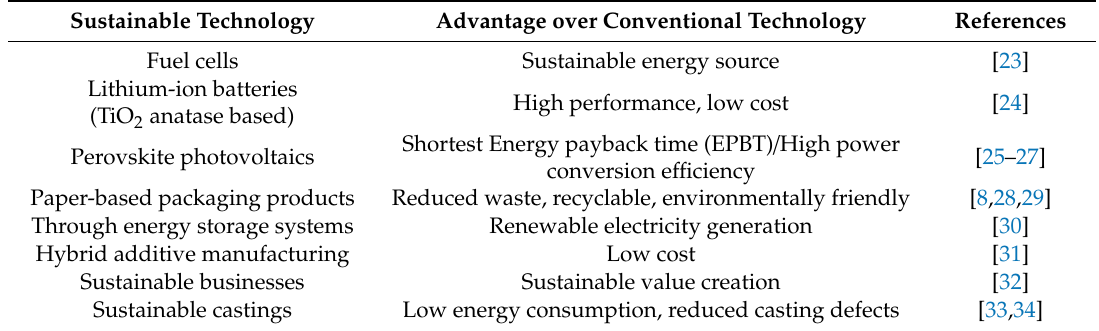
Table 1. Sustainable technologies and their benefit over conventional technologies.